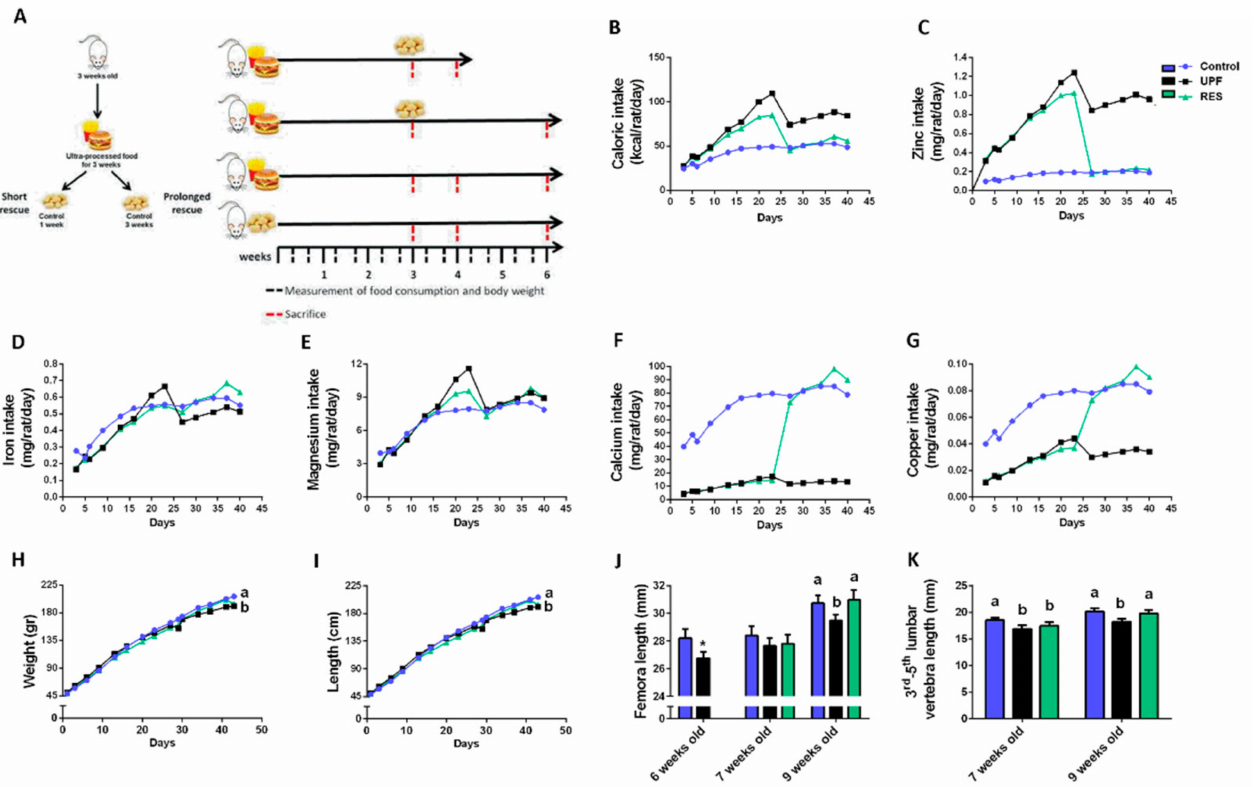
Figure 7. Transition from exclusive ultra-processed food (UPF) consumption to a balanced diet leads to a compatibility between the caloric intake and micro-nutrient consumption and catch-up